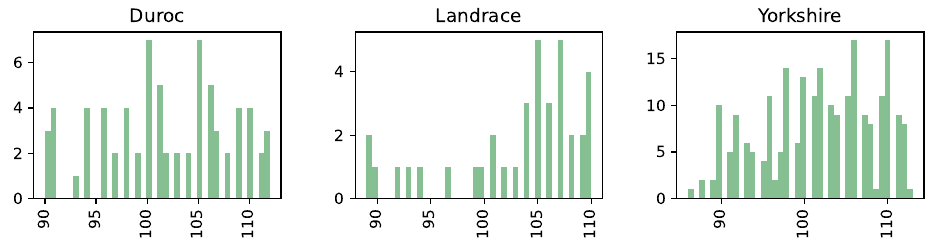
Figure 1. Histogram of the distribution of the live weight by breed.